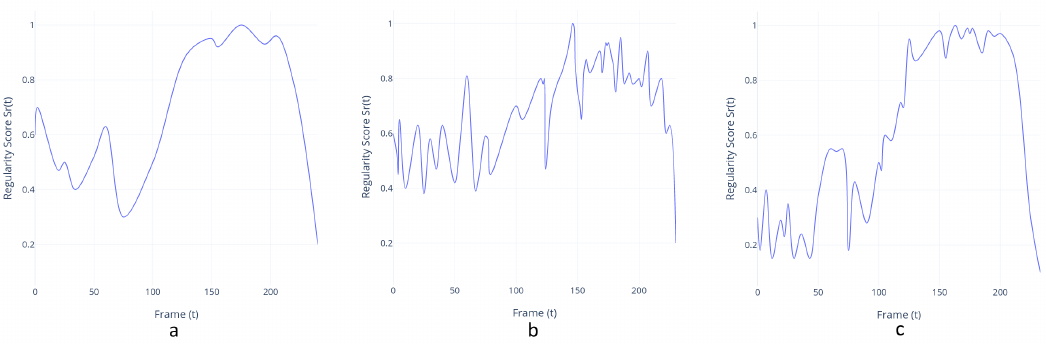
Figure 22. Regularity curves ( top - left ) with a bag-snatching scenario using three preprocessing methods: ( a ) MOG2 background subtraction, ( b ) frame subtraction (absdiff), ( c ) Farneback optical flow.